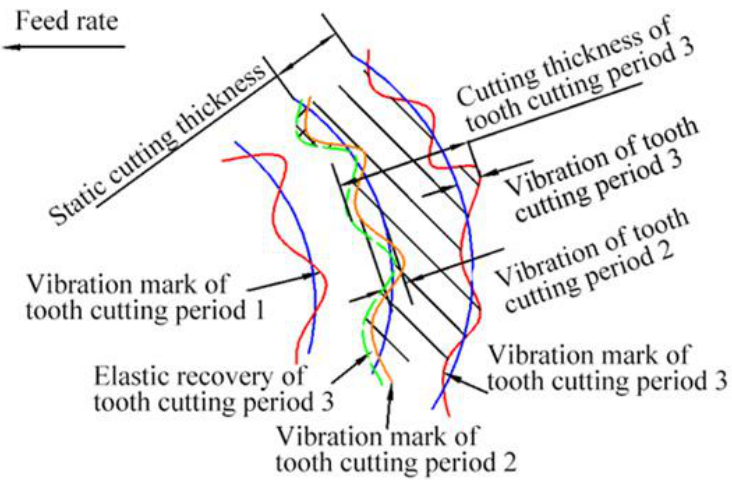
Figure 12. Instantaneous cutting thickness during micro-milling when tooth immerses in the workpiece. It is assumed that the cutter tooth immerses in the workpiece in tooth cutting period 1. tooth loses contact with the workpiece in tooth cutting period 2. Chatter mark is not left on workpiece surface. The nearest to the chatter mark in tooth cutting period 3 is the mark left in tooth cutting period 1. Because cutting does not occur in tooth cutting period 2, static cutting thickness resulting from feed per tooth in period 2 is not yet removed and needs to be removed in tooth cutting period 3. On the aspect of machined surface elastic recovery, because cutting does not occur in tooth cutting period 2, machined surface elastic